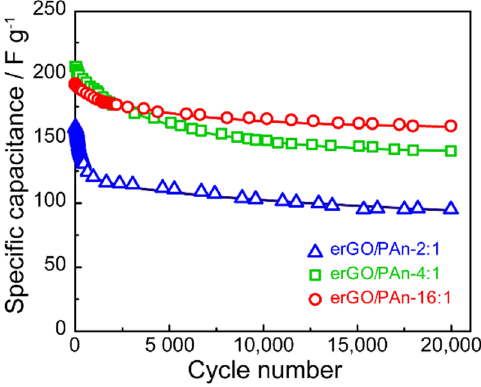
Figure 9. Changes in specific capacitance cycle number for composite films of erGO/PAn.